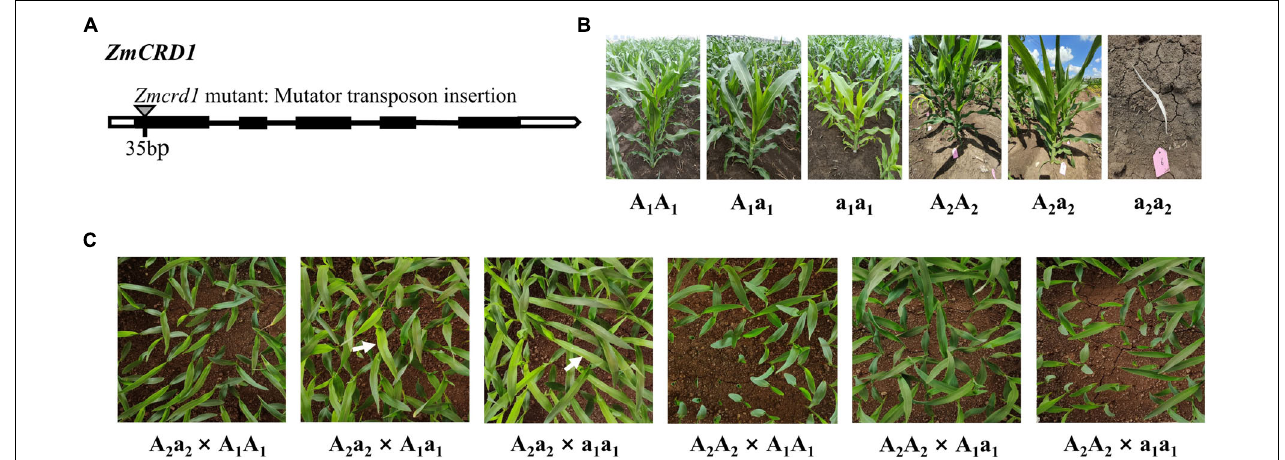
FIGURE 3 | The functional complementation assay between the pgl mutant and Zmcrd1 mutant. (A) The structure model of mutator insertion in the ZmCRD1 gene. (B) Phenotypic identification of mutational individuals of different genotypes used for the complementation allelic test. (C) Genetic analysis of pgl and Zmcrd1 associated F 2 populations. Seedlings were grown to the third-leaf stage in greenhouse and then subjected to phenotyping. The white arrows point to the individuals with mutated phenotype.